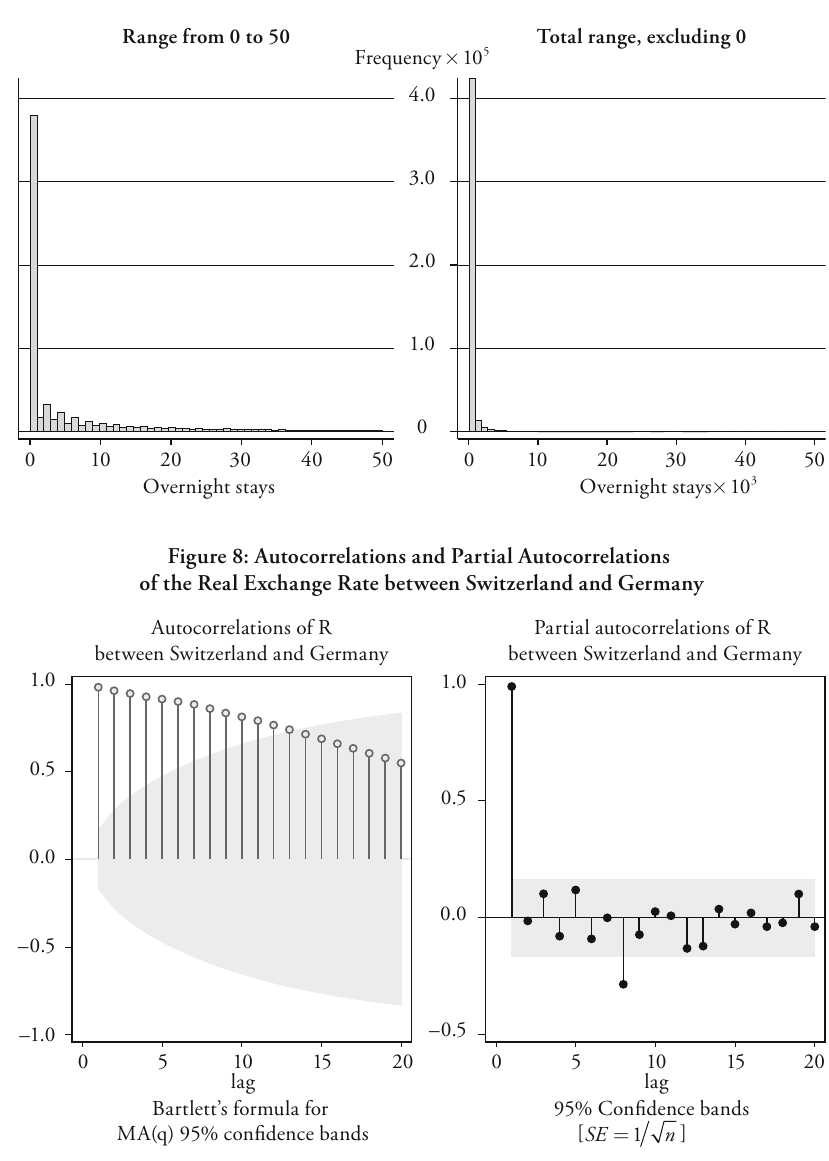
Figure : Overnight Stays: Distribution of the Observations